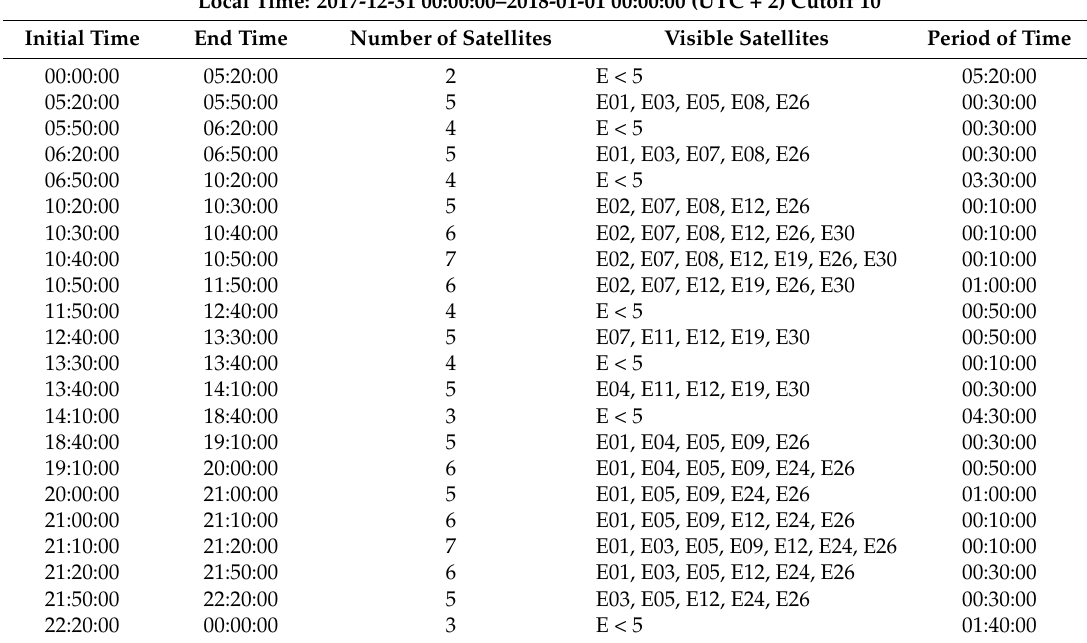
Table 4. Galileo satellites availability for the Day of Year: 365, 2017.